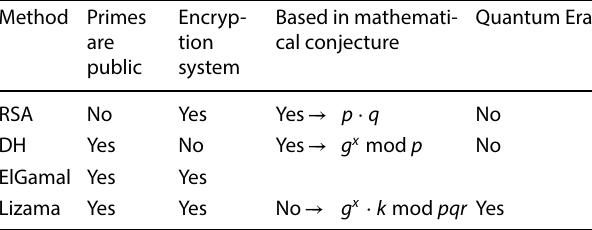
Table 9 Comparison between public cryptosystems Based in mathemati- Encryp- Method Primes cal tion are system public